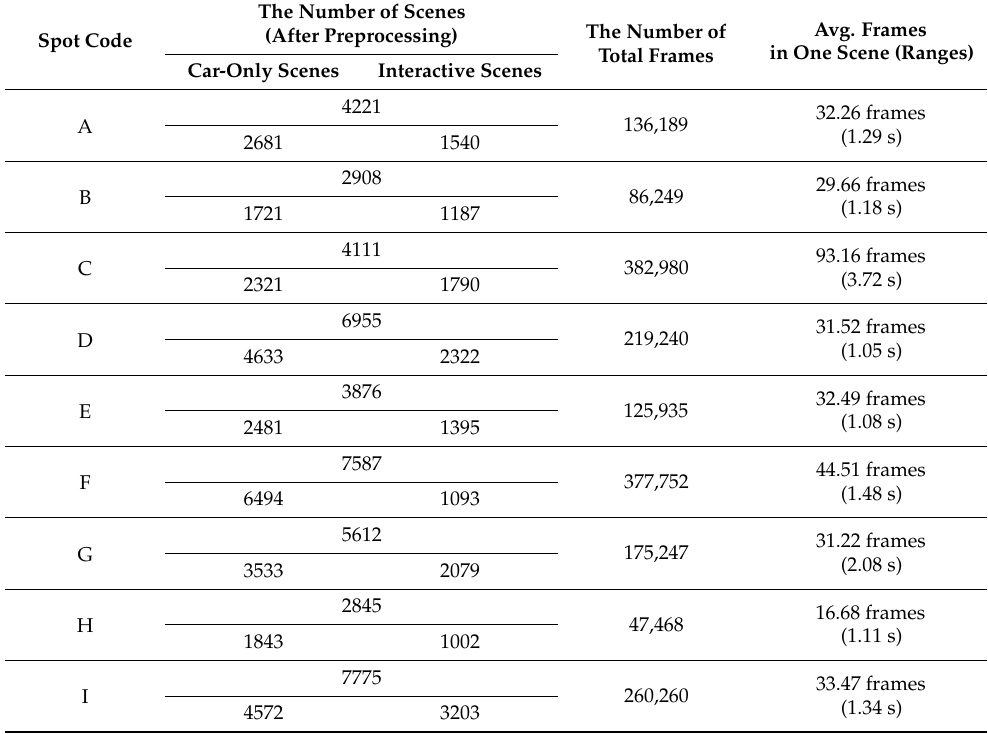
Table 2. The number of the extracted scenes after preprocessing. The Number of Scenes (After Spot Code